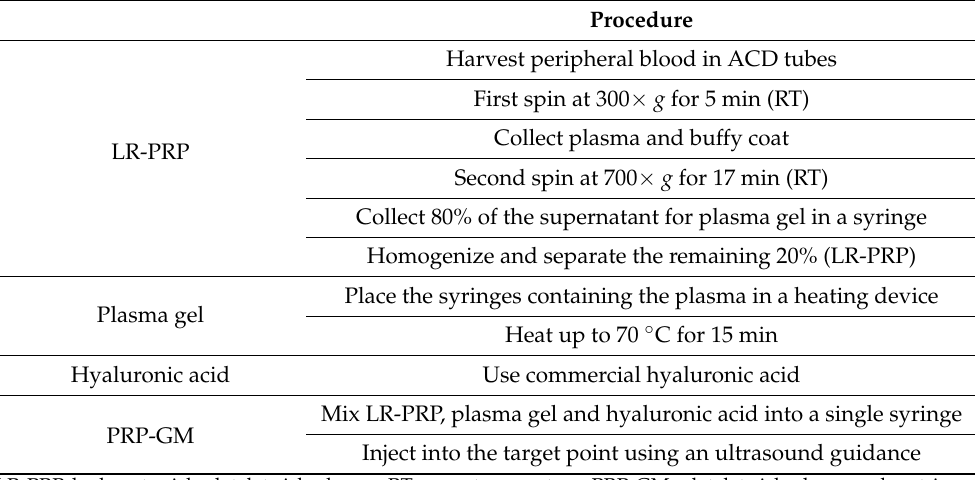
Figure 4. Last step before infiltration. ( A ) The mixed buffy coat and plasma gel are homogenized with hyaluronic acid to obtain the PRP–HA cellular gel matrix; ( B ) The final product, ready for use. Table 1. Methods and materials to obtain the